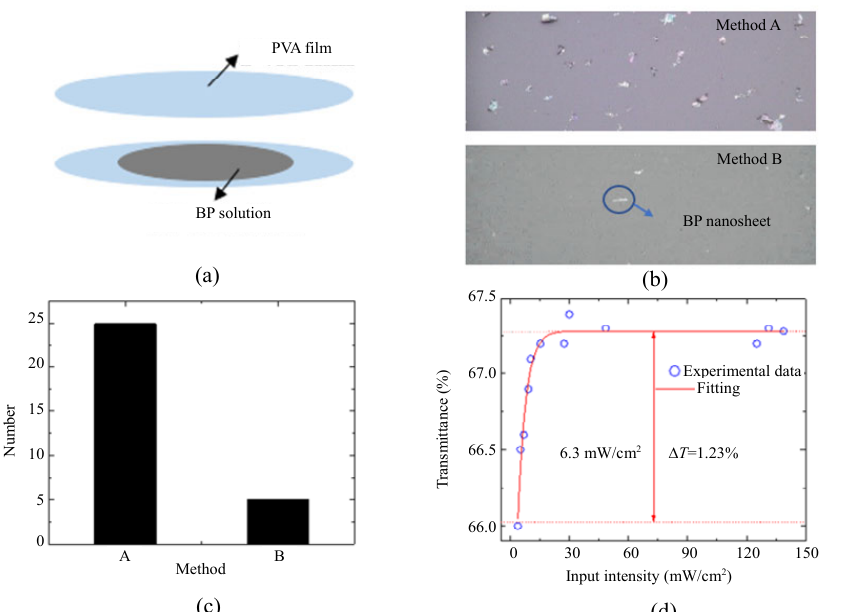
Fig. 2 Preparation of PVA-BP-PVA film and the saturable absorption measurement of BP-SA: (a) schematic diagram of the fabrication process of PVA-BP-PVA film, (b) picture of BP-film which is fabricated by improved drop-casting method (method A) and wet-chemistry techniques (method B), (c) statistics on the amount of BP nanosheets, and (d) the nonlinear saturable absorption of BP-SAs. BP: black phosphorus; PVA: polyvinyl alcohol; SA: saturable